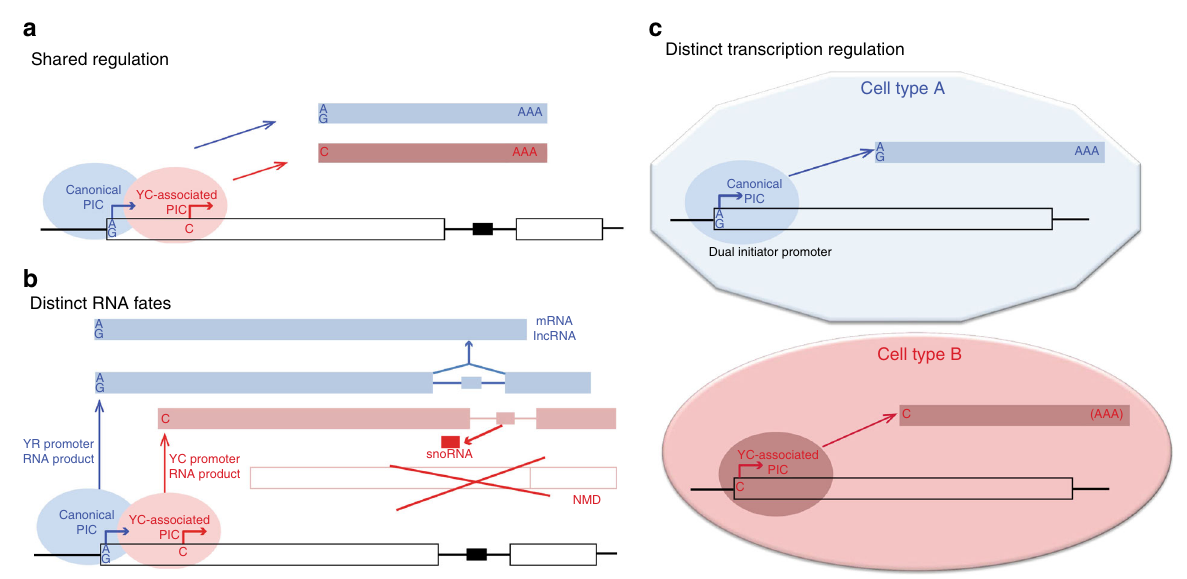
Fig. 8 Models for utilization of dual-initiation promoters during development. a Dual-initiation promoters can be occupied by pre-initiation complexes (PIC) in a cell to generate two RNA products with distinct 5 ′ end base. These products can be produced on a shared promoter coordinately by partially overlapping PICs or by distinct PICs recruited coordinately. The co-regulation may occur on the cell or tissue level. b Model for differential utilization of YC and YR-initiation by divergent PICs to generate RNAs with distinct fate in the same or distinct cells. E.g. PICs form on the YR-initiation site for generating a protein coding mRNA or non-coding RNA gene product from a snoRNA host gene, while the YC-initiation may be utilized by a specialized PIC to produce an RNA which is processed to splice out snoRNAs and subjected to distinct degradation pathways. c A dual-initiation promoter is utilized divergently by YR and YC associated initiation complexes to adapt to requirements in different cells such as maternal activity in the oocyte versus zygotic activity in an embryonic YC-initiation remained unexplored. Reinvestigation of human and Drosophila cell line datasets in this study demonstrated that the dual-initiation is a widespread phenomenon and share similar sequence features, promoter shapes, expression levels and enri- ched gene ontology. Thus, dual-initiation promoter genes in three major metazoan model systems suggest an evolutionary ancient, shared promoter architecture with fundamental multicellular function in development and motivates future investigation into the regulation and consequences of selective transcription initiation within gene promoters in general.